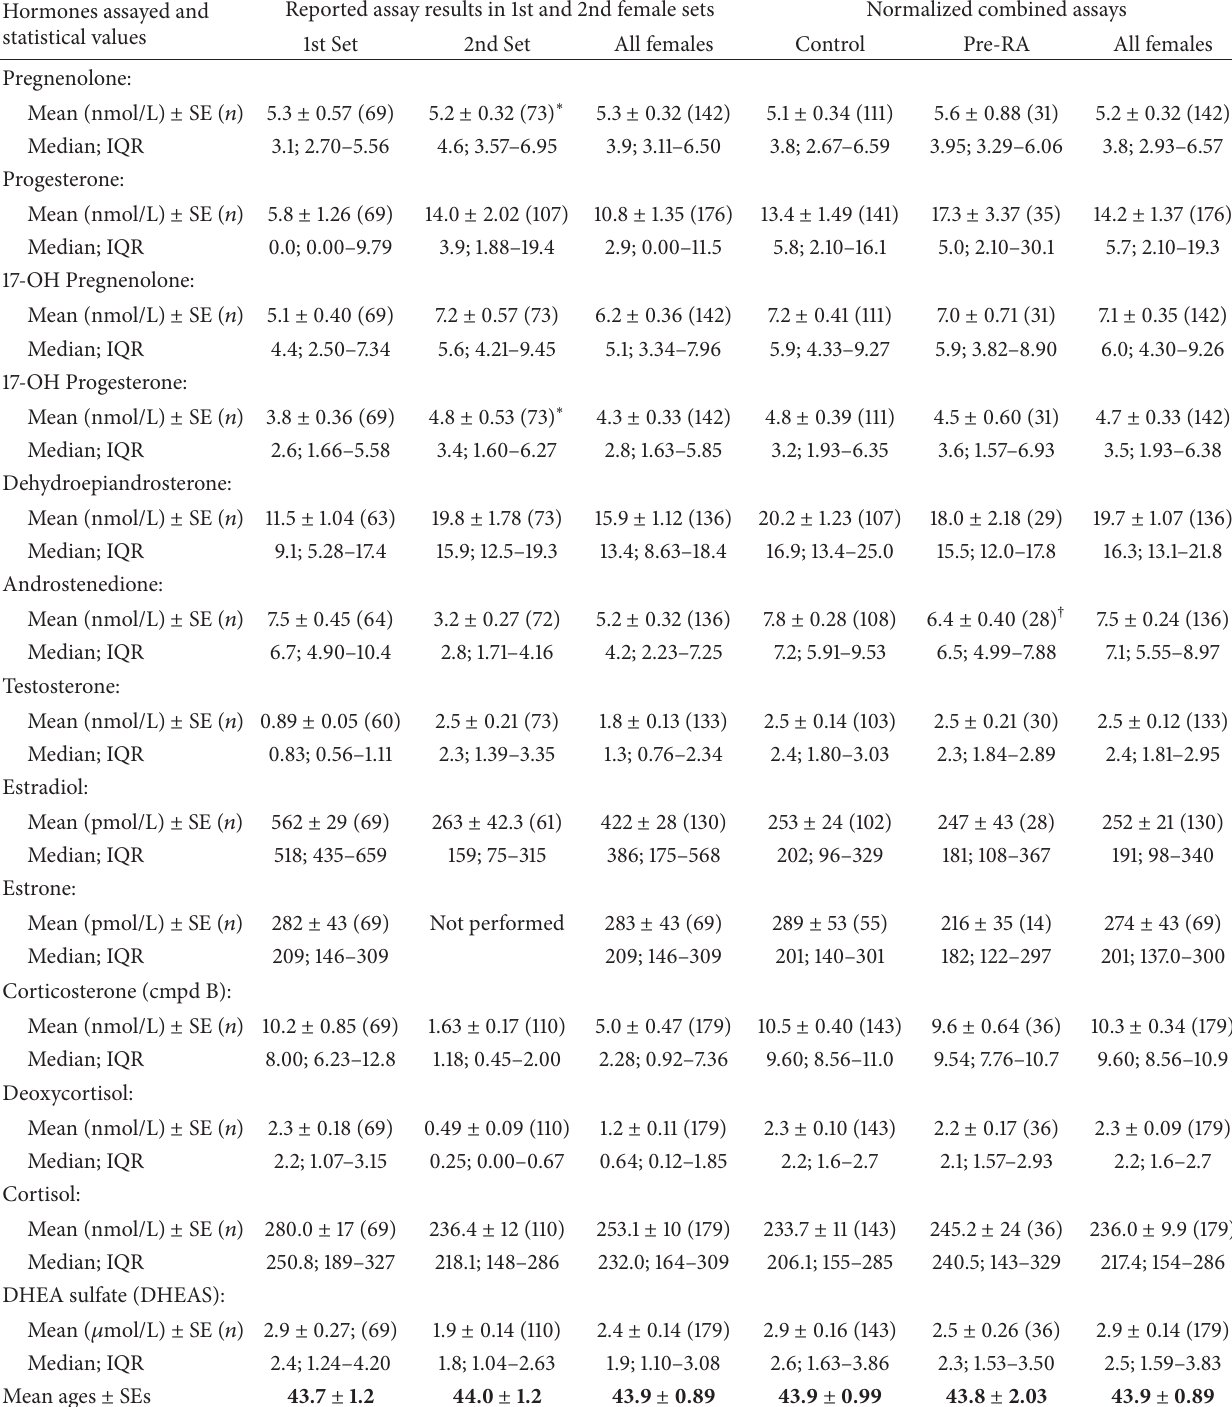
Table 1: Hormones reported by the referral laboratory in a first (1992) and second (1994) set of assays. Hormones assayed